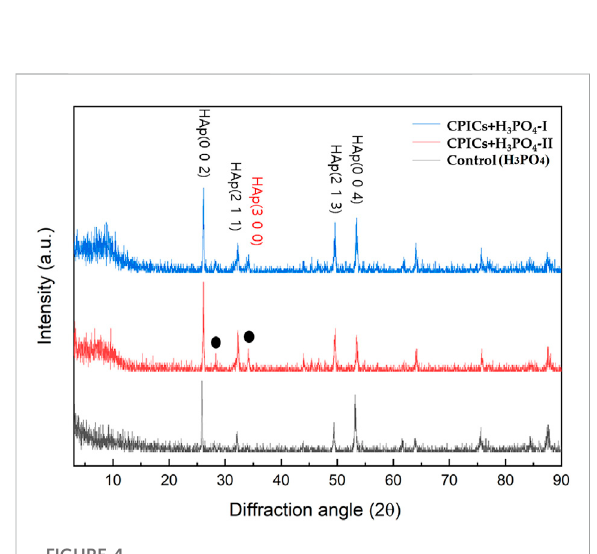
FIGURE 4 X-raydiffraction(XRD)patternsfromtheacid-etched enamel specimens (control, CPICs + H 3 PO 4 -II, and CPICs + H 3 PO 4 -I). The black dots and red letter are showing a new HAp peak (ICDD 98 – 000 – 1706) that revealed the degree of enamel remineralization